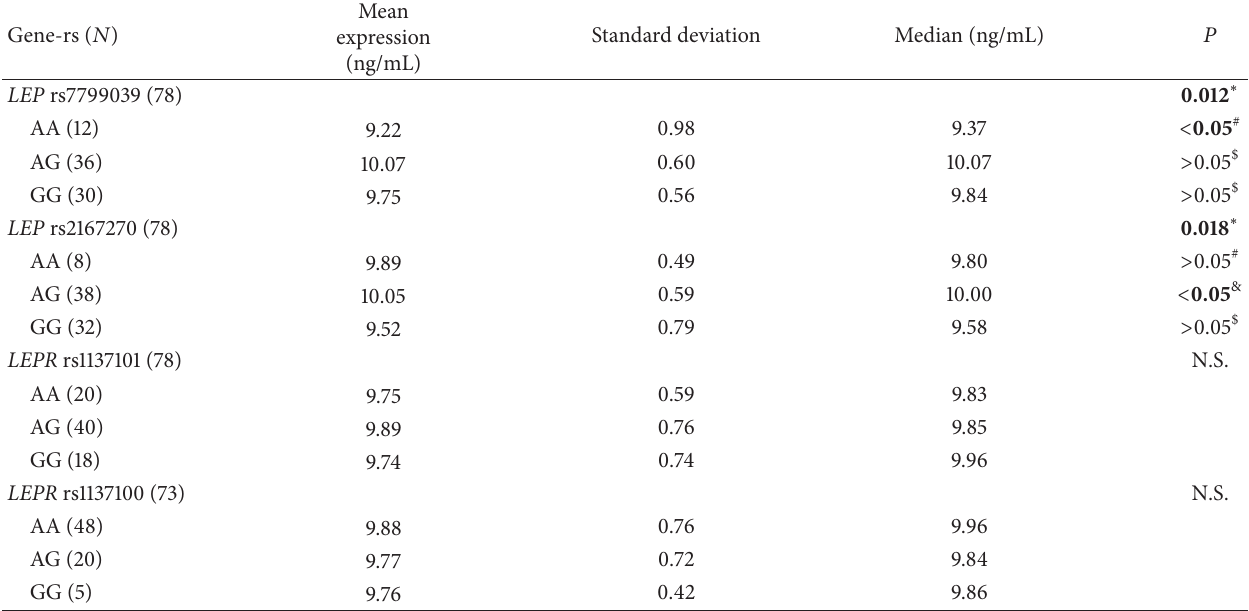
Table 3: Mean and median leptin serum expressions according to the genotypes of the studied